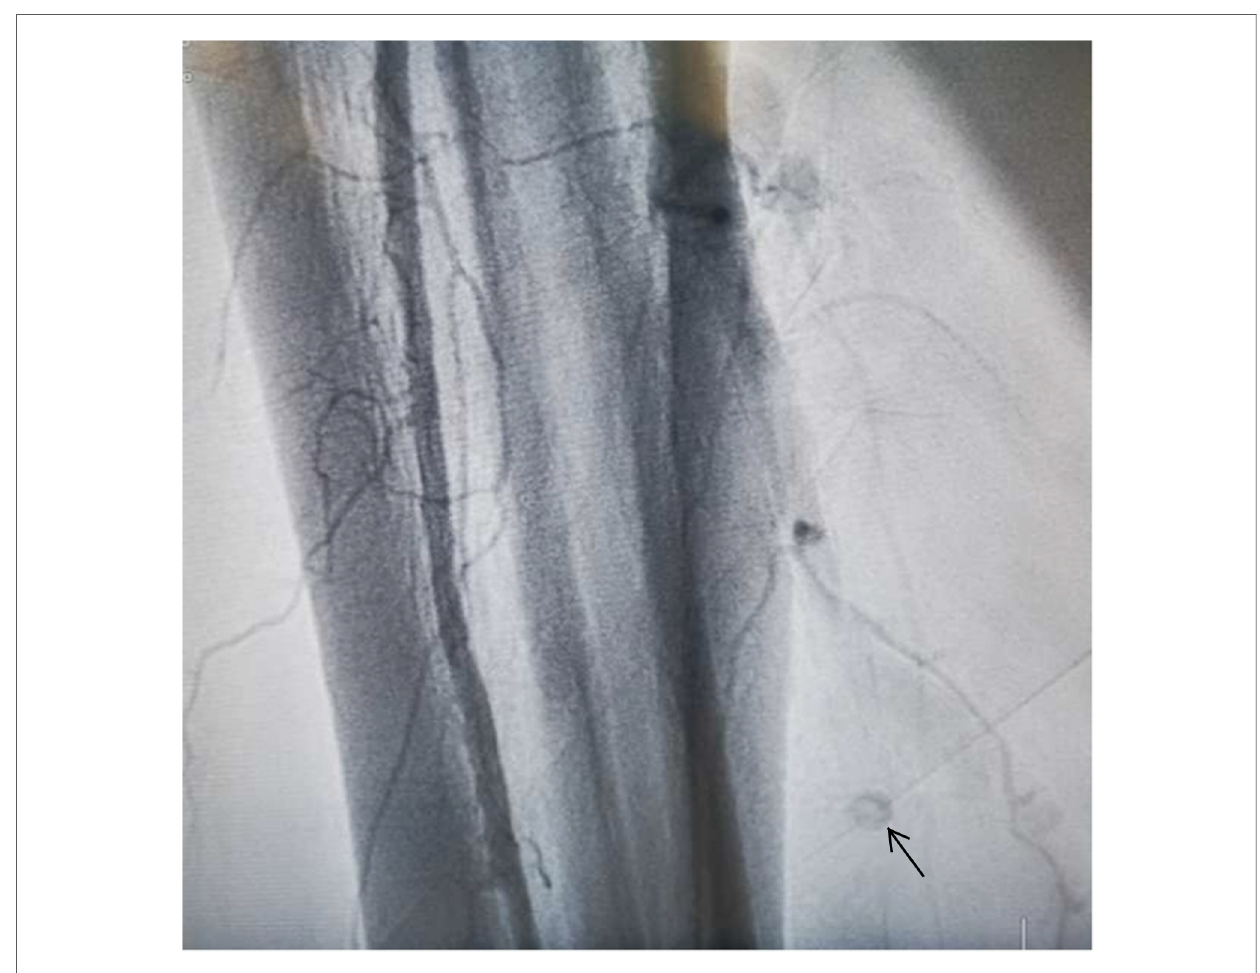
FIGURE 5 Lower limb artery angiography showing a fi lling defect (dark arrow) in the right peroneal artery.